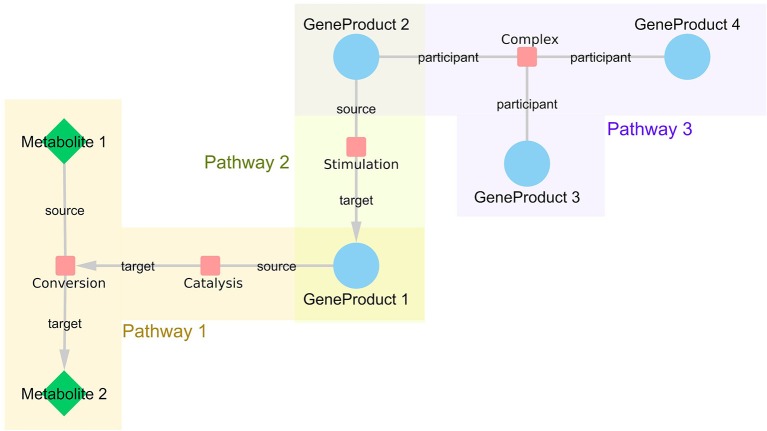
WikiPathways network structure. Every interaction is represented as a node in the network with links to all participants. If the interaction is directed, the information about source and target nodes is added as an edge attribute. The nodes represented as small, red rounded rectangles are interactions, blue circles represent gene products and green diamonds embody metabolites. Interactions that share certain participants, such as GeneProduct 1, are brought close together in the resulting network even if they are from different pathways, such as Pathway 1 and 3.